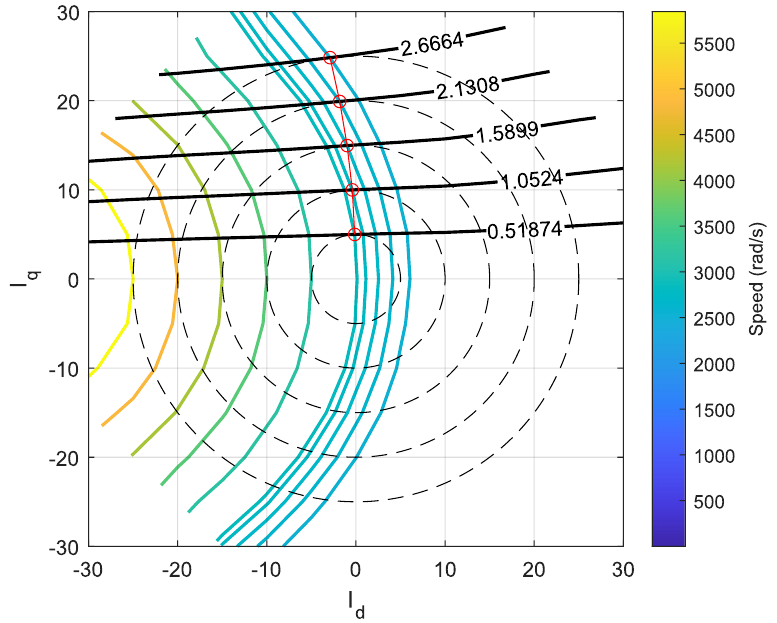
Figure 25. Torque, flux − linkage and current limits in ( I d , I q ) plane, experimental